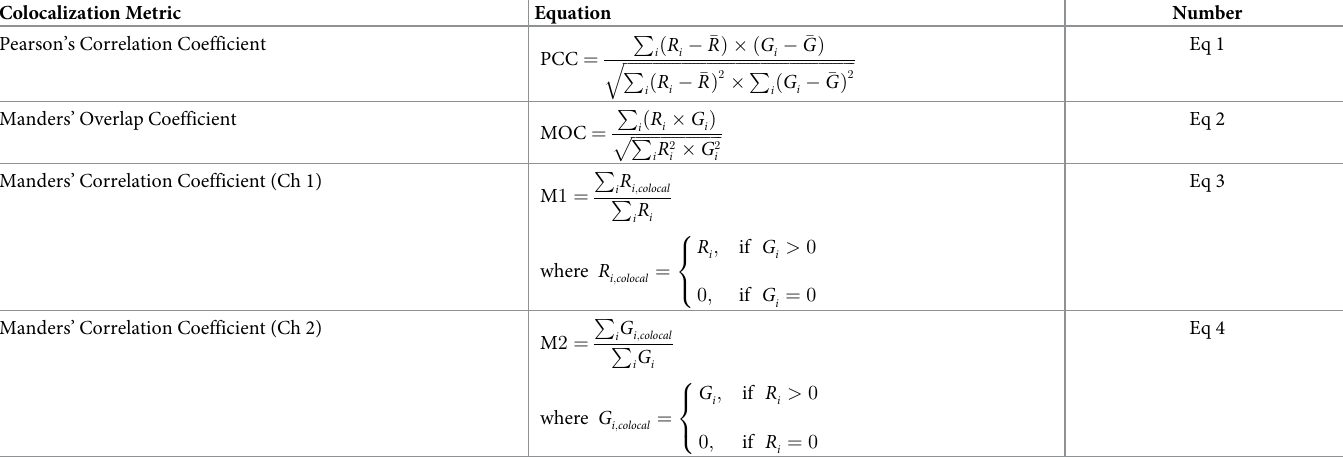
Table 1. Colocalization metrics R i represents the intensity of voxels in channel 1 (red fluorescent label) and G i represents the intensity of voxels in channel 2 (green fluorescent label). (cid:22) R and (cid:22) G represent the mean intensities of the respective channels